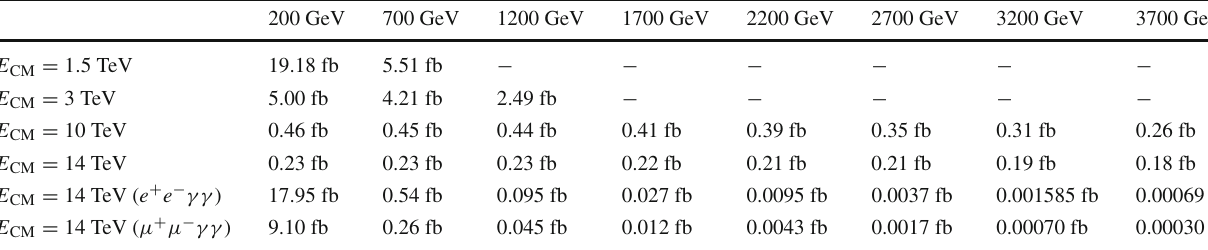
Table 7 Singlet VLL double production cross-section at lepton collid- ers. As idicated in the top row of the table, all considered mass values correspond to the bold benchmark point in Eq. (15). We show the cross- section for a centre-of-mass energy E CM = 1 . 5 and 3 TeV, which are